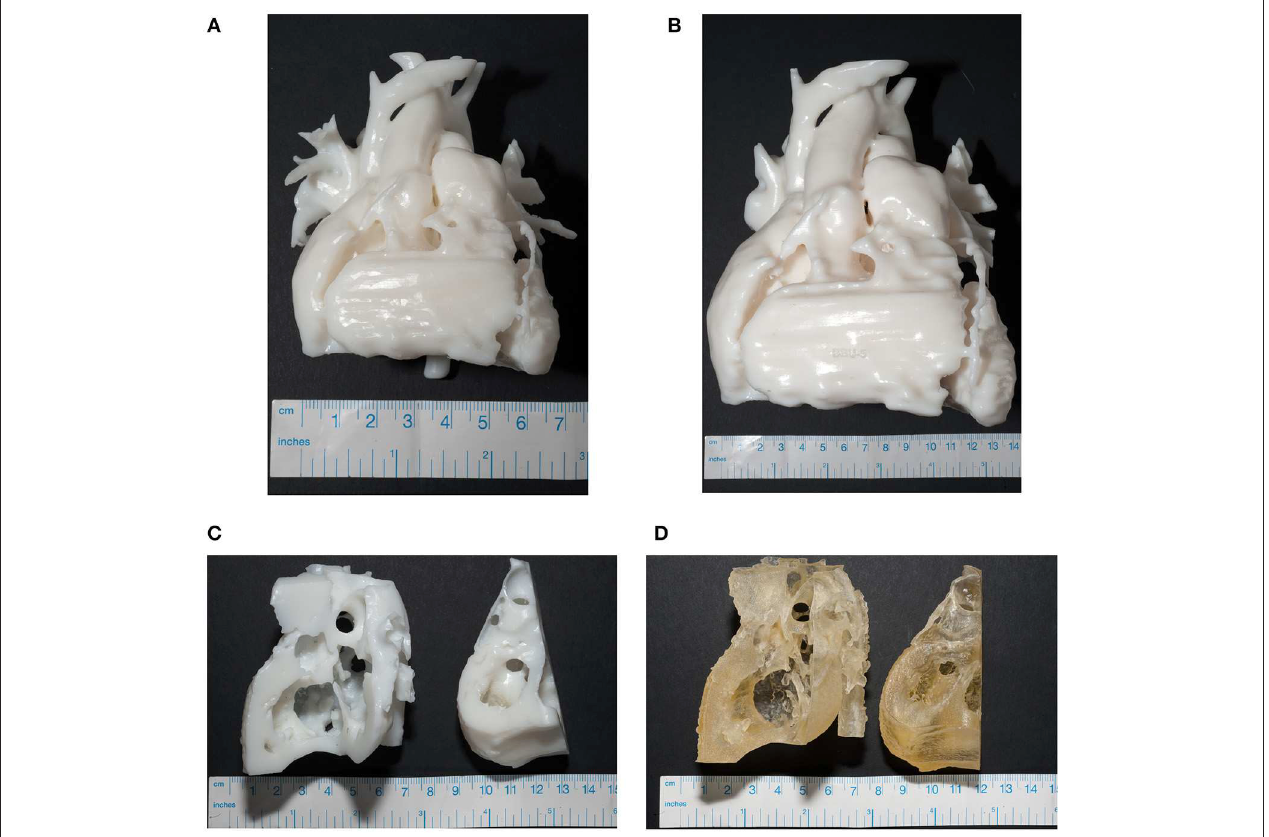
FIGURE 2 | Photographs of the final models, with a measuring tape to demonstrate size. (A) The finished blood pool model at 1:1 size. (B) The 2:1 sized blood pool model, both produced in Formlabs White resin. Myocardium models were produced in Formlabs White resin (C) and using the polyjet printer in Agilus30 (D) .